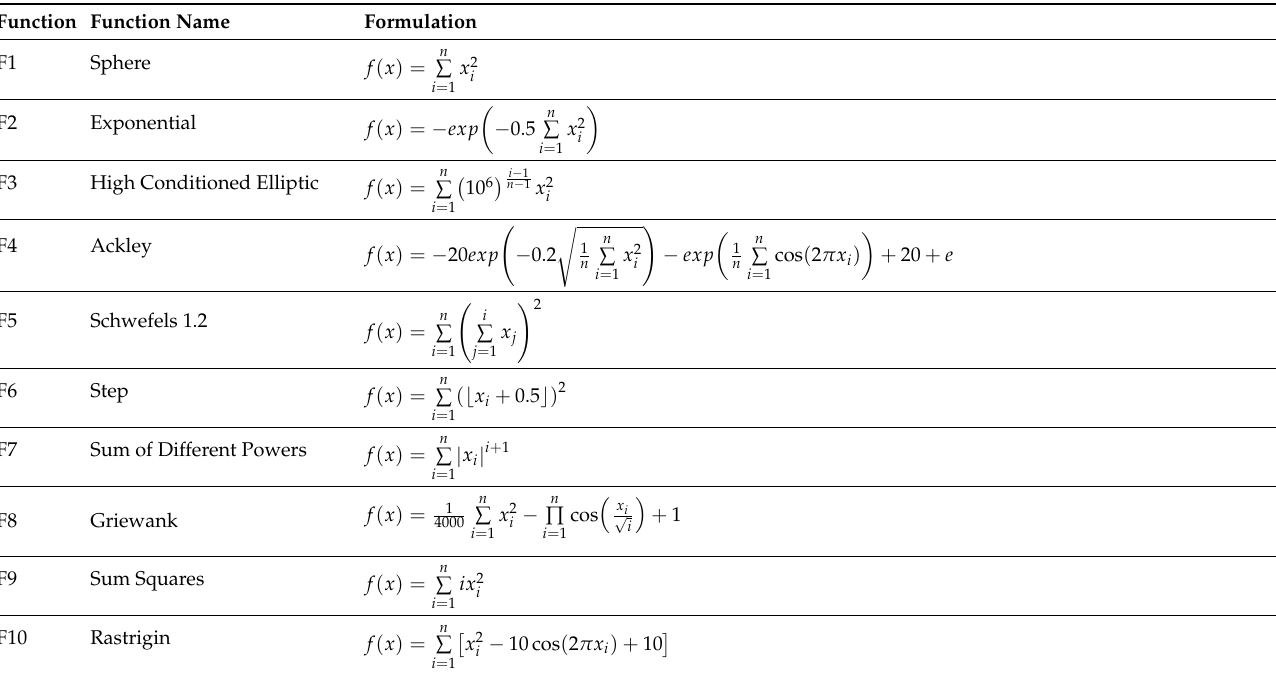
Table 1. Benchmark functions used for solving global optimization